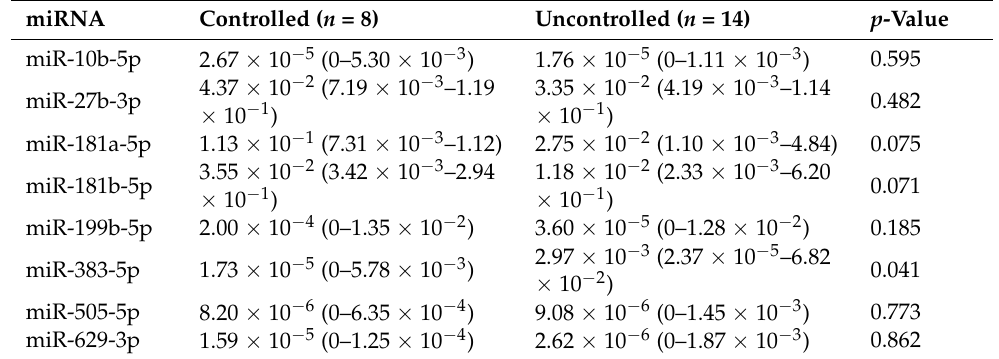
Table 4. Median miRNA qPCR relative expression (minimum and maximum values) in each